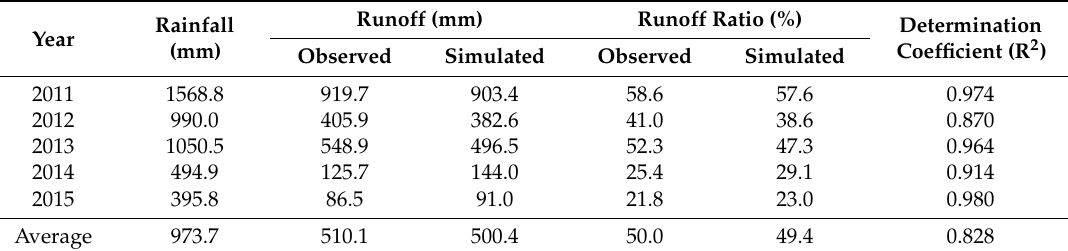
Table 4. Runoff ratio and Determination coefficient.